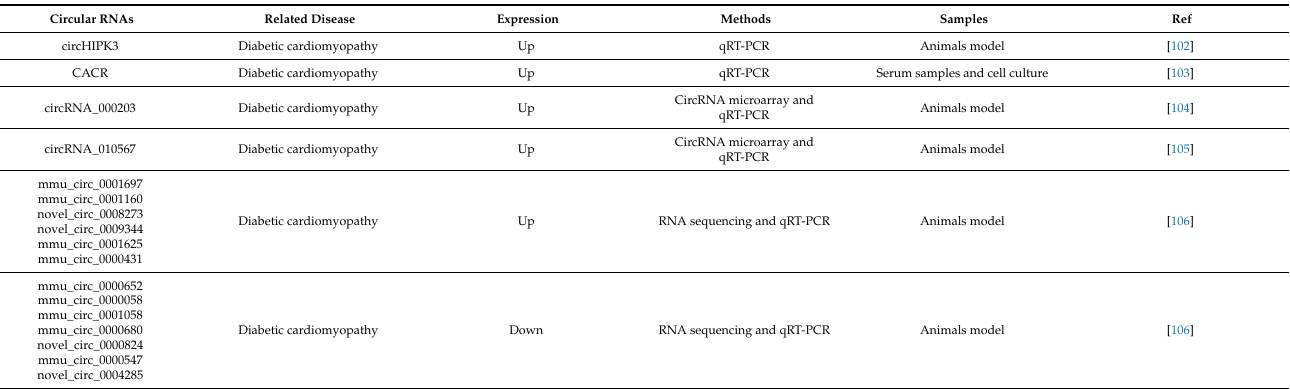
Table 3. The circular RNAs involved in diabetic